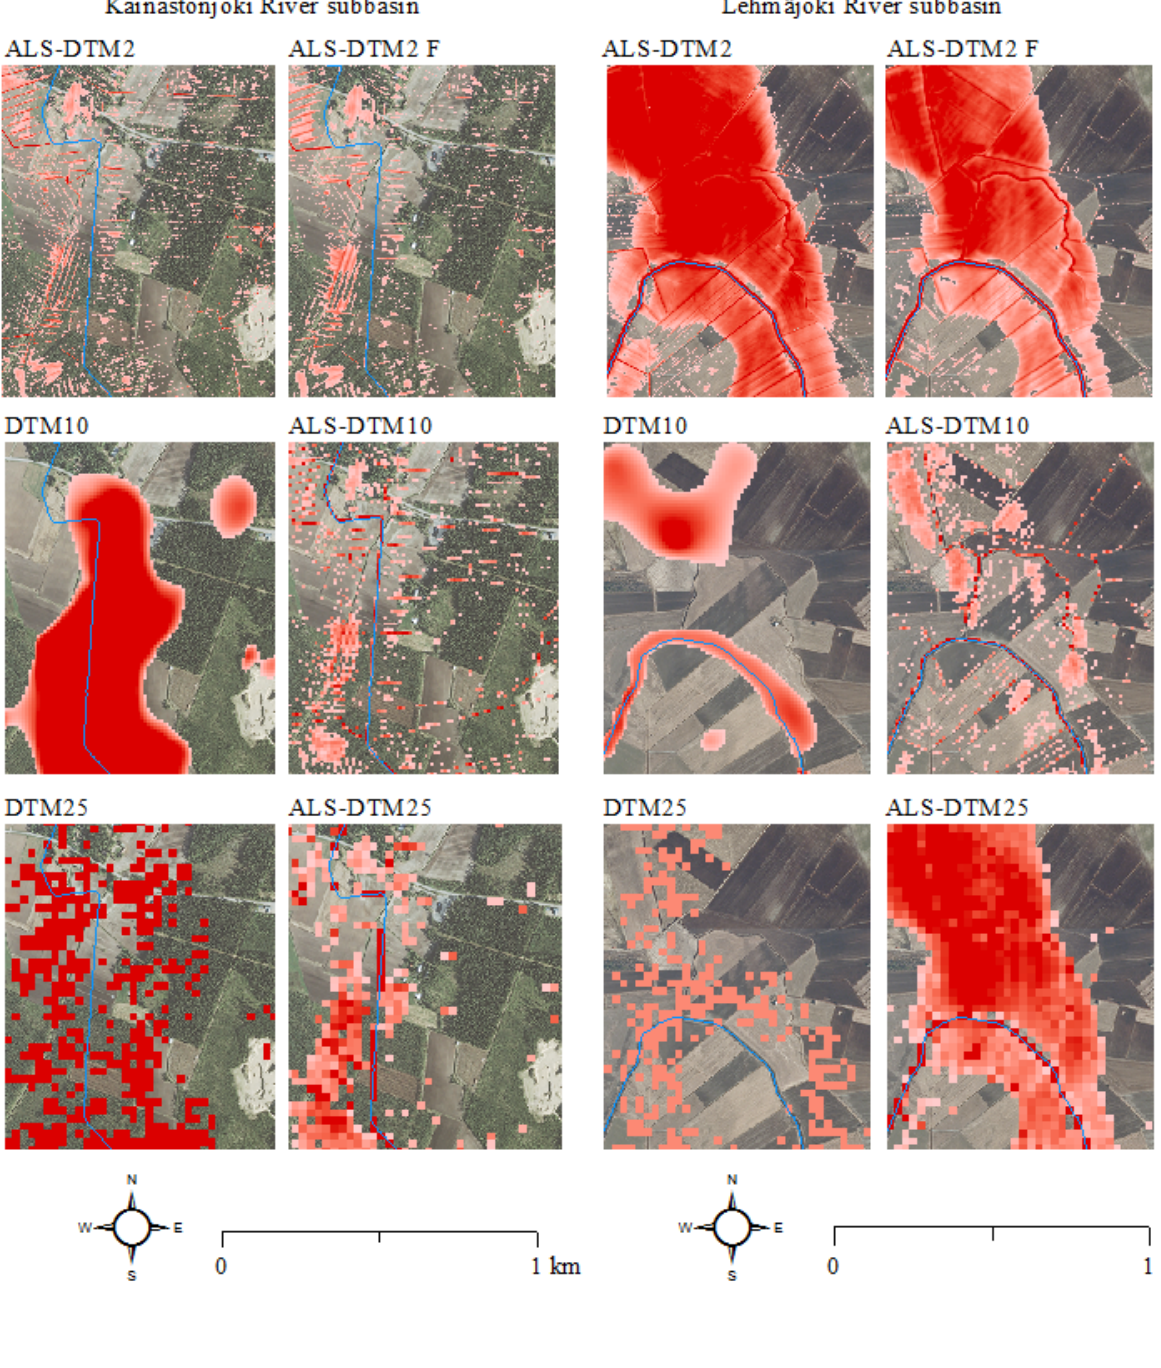
Figure 7. Terrain and depression representations of DTMs studied. An aerial photograph acts as a background. The blue line illustrates the stream channel and red depressions; when the tone gets darker the depression pixels are